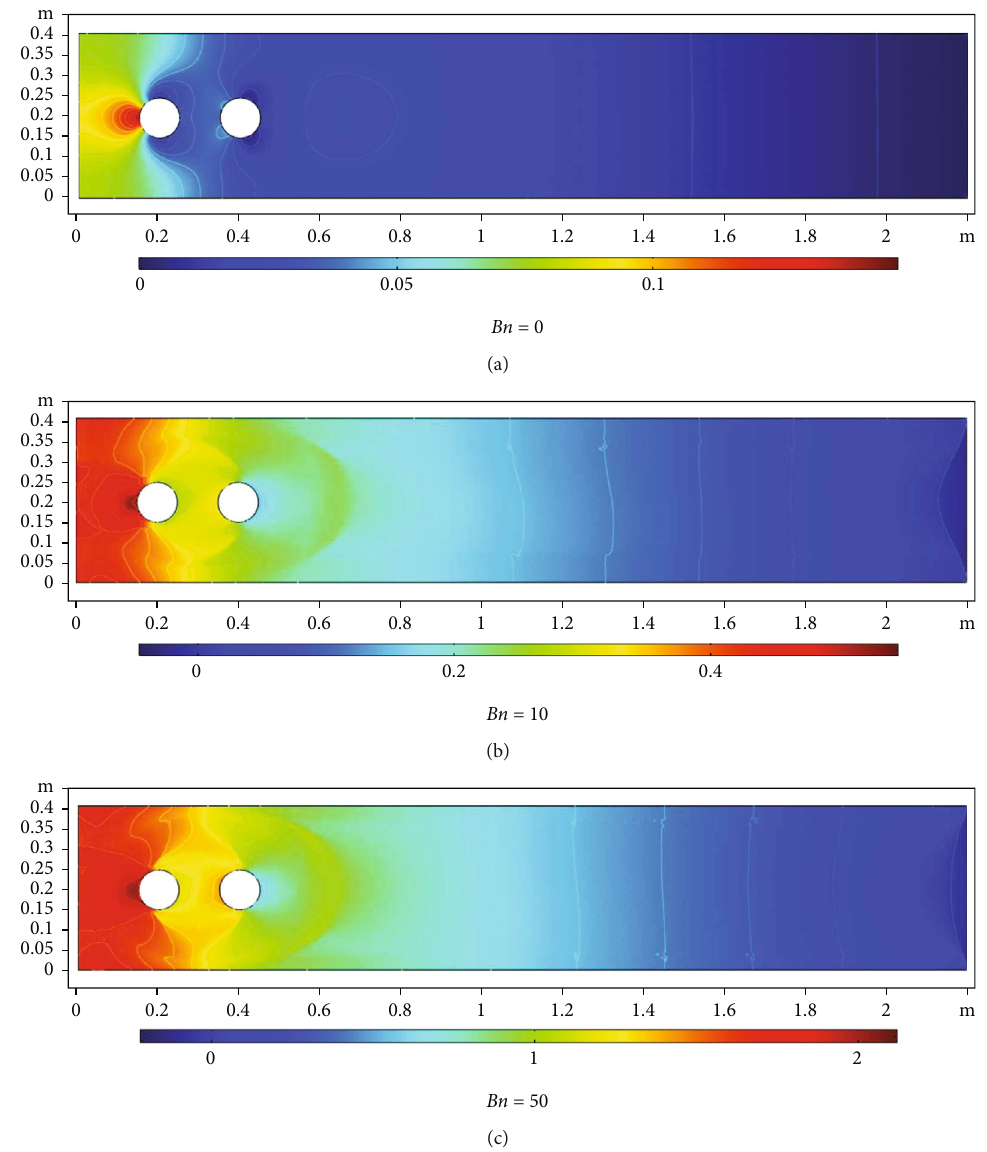
= 0 : 1 and Re = 20 .(a) Bn = 0 . (b) Bn = 10 . (c) Bn = 50 p